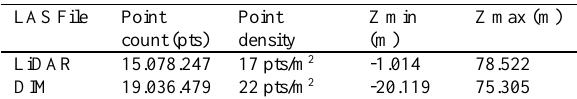
Table 3. Properties of each point cloud dataset.